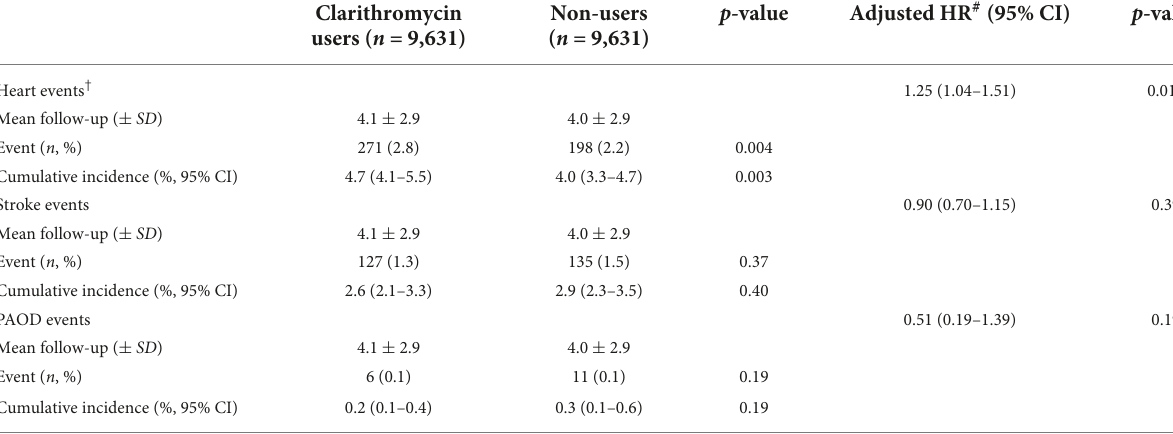
TABLE 3 Individual event of cardiovascular morbidity associated with clarithromycin